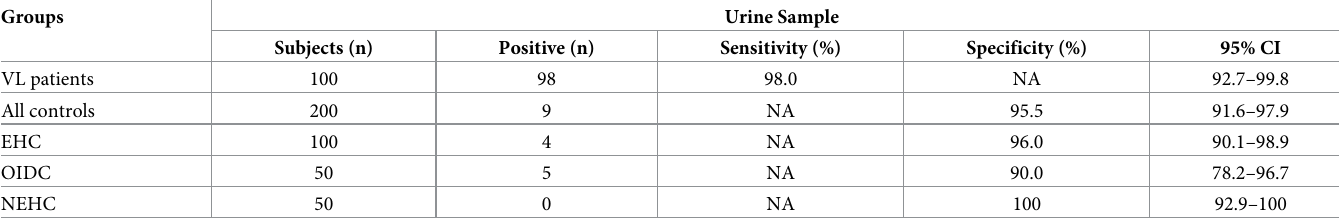
Table 3. Sensitivity and specificity of rK-39 ICT test performed using urine sample from VL patients and non-VL individuals for diagnosis of VL.